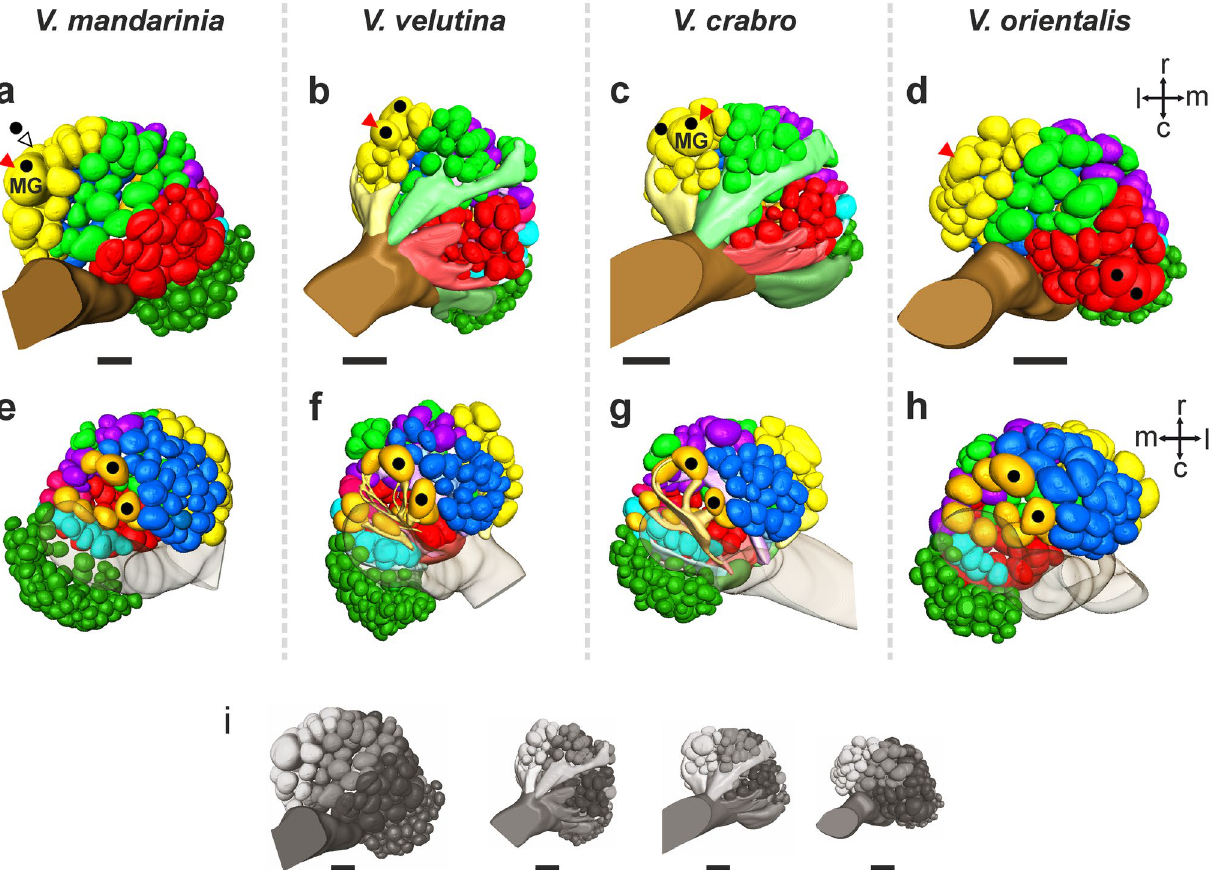
Figure 2. 3D reconstructions of the antennal lobes of four hornet species. 3D models of the antennal lobes of V. mandarinia ( a , e ), V. velutina ( b , f ), V. crabro ( c , g ) and V. orientalis ( d , h ) are represented in a ventral view ( a , b , c , d ) or in a dorsal view ( e , f , g , h ). All lobes are scaled to the same size in ( a – h ) for easier comparison (scale bar = 100 µm). The glomerular clusters are colour-coded according to their homology across species, using the same colors as the subtracts in Fig. 1 (orange: T A ; dark green: T B ; light blue: T C ; dark blue: T D ; Pink: T E ; purple: T F ; red: T G ; yellow: T H ; light green: T I ). Black dots indicate the four largest glomeruli in the antennal lobe of each species. The red triangle shows a possibly homologous glomerulus in the 4 species. MG stands for macroglomerulus and relates to the volumetric measures shown in Fig. 4. For reference, all lobes are represented according to their true relative sizes in ( i ) (scale bar = 100